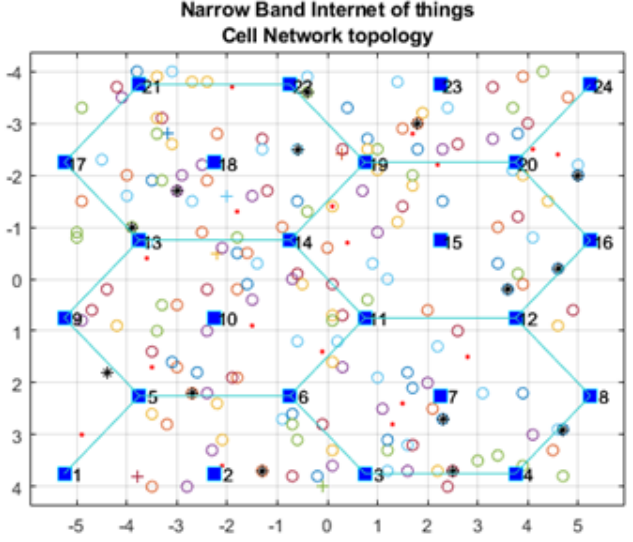
Figure 2. NB-IoT attocell networking topology and field